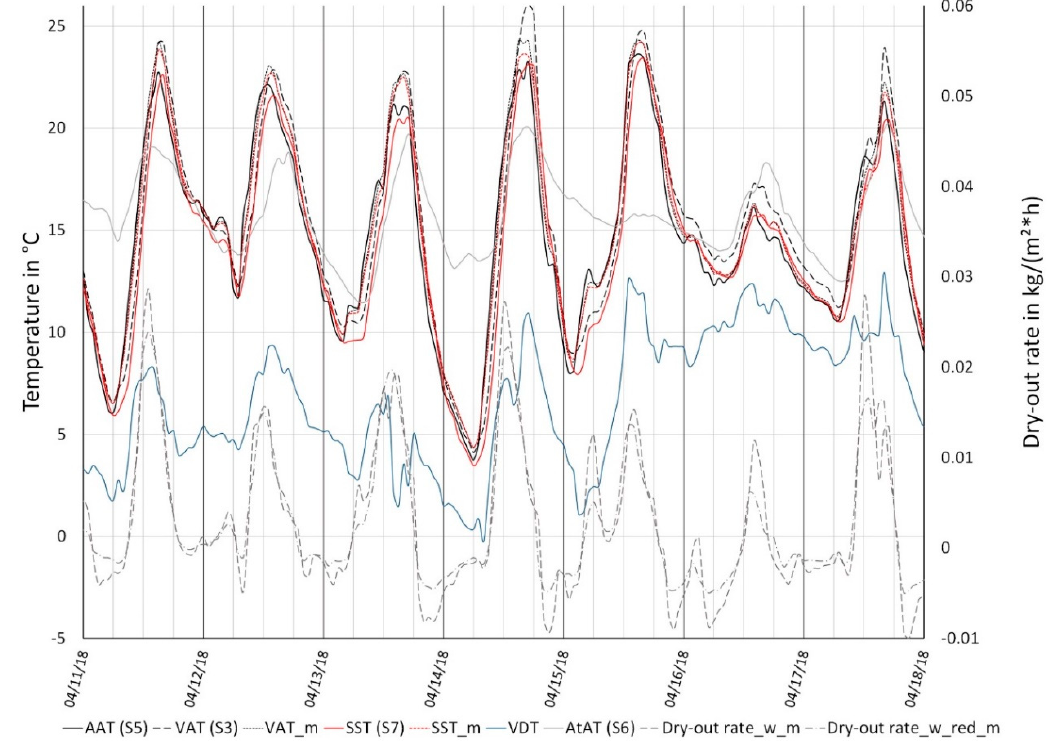
Figure 5. Various temperatures and dry-out rates of the lower shingle layer in spring 2018.